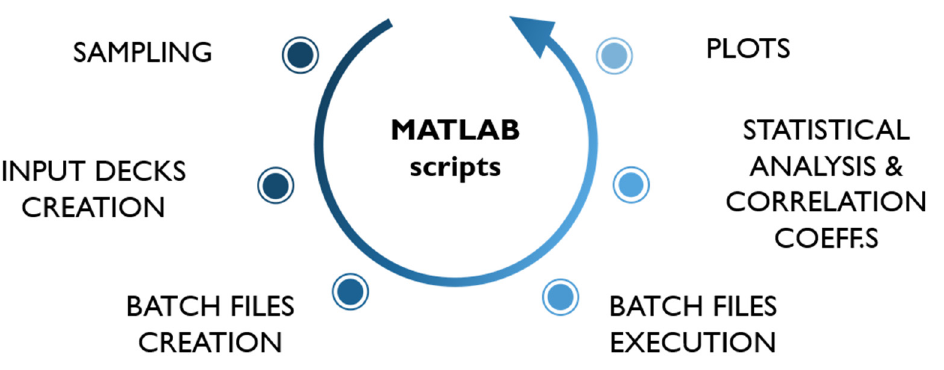
Figure 3. The MATLAB scripts—process flow.